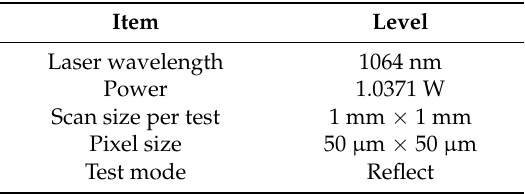
Table 4. Parameters of weak absorption.